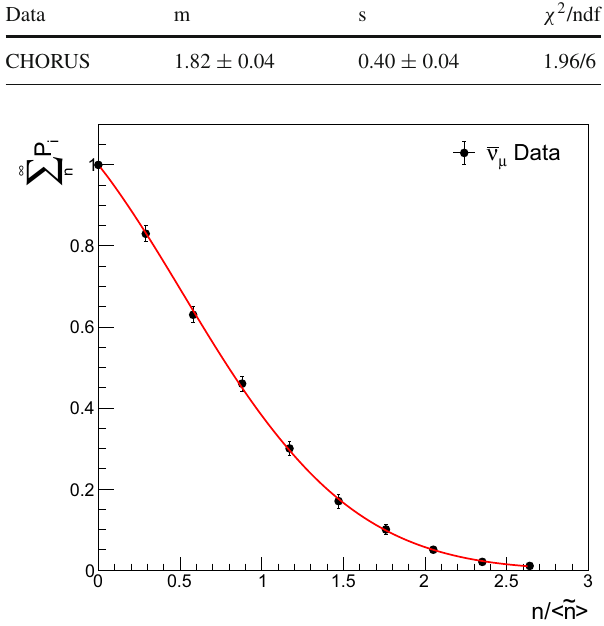
data together with the parameters given in Table 2 indicate that LND provides a good description of the ¯ ν μ CC interac- tions as